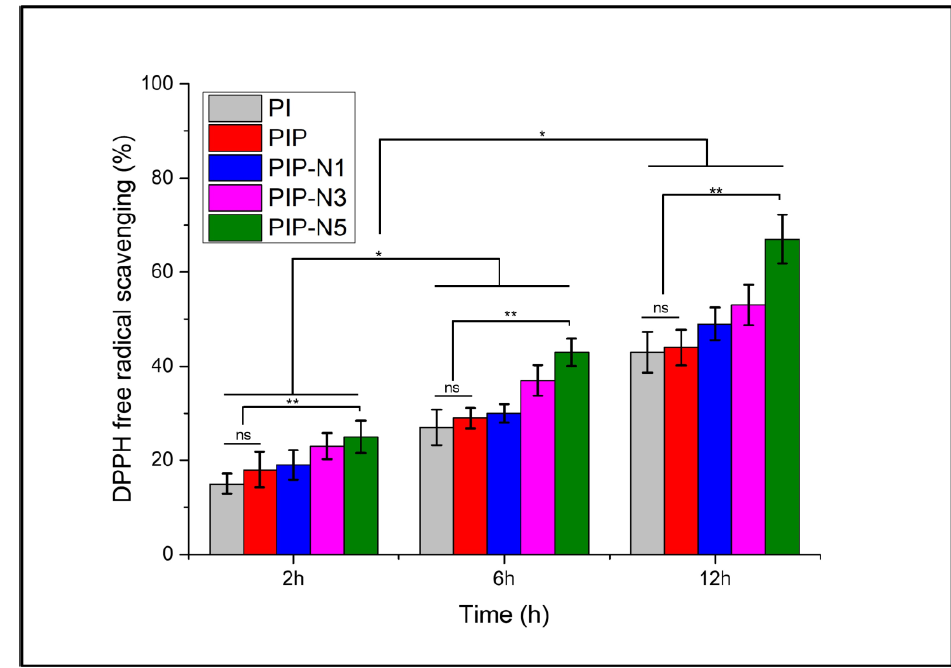
Figure 12. DPPH free radical scavenging activity of produced films (n = 3; mean ± SD, ns: p > 0.05 no significant difference, * p < 0.001 between time intervals, and ** p < 0.0001 against films with no niaouli oil).